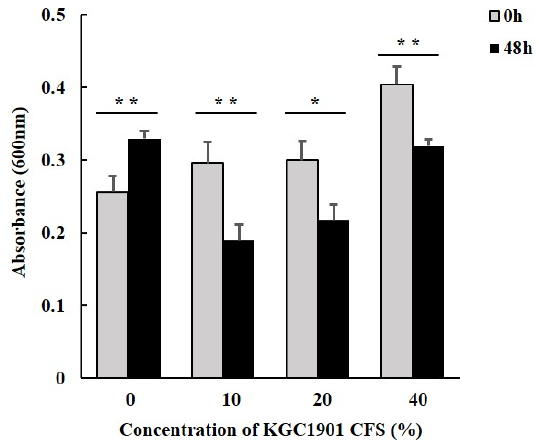
Figure 5. Antimicrobial activity of L. reuteri KGC1901 against Clostridium difficile . C. difficile was cultured in BHI with KGC1901 CFS and the absorbance of the culture soup was measured. As a result, the growth of CD was suppressed on the media added with 10%, 20%, and 40% of KGC1901 CFS. Significant correlations between 0 h and 48 h of each concentration are shown by asterisks (* p < 0.05, and ** p < 0.01).